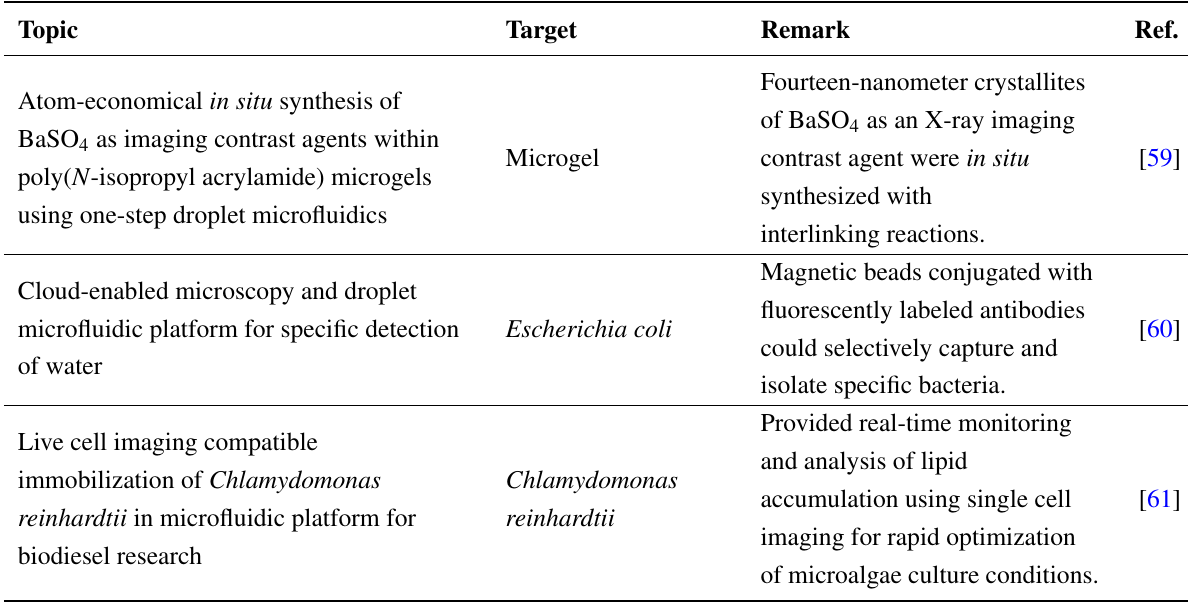
Table 2. Recent applications of droplet microfluidics in